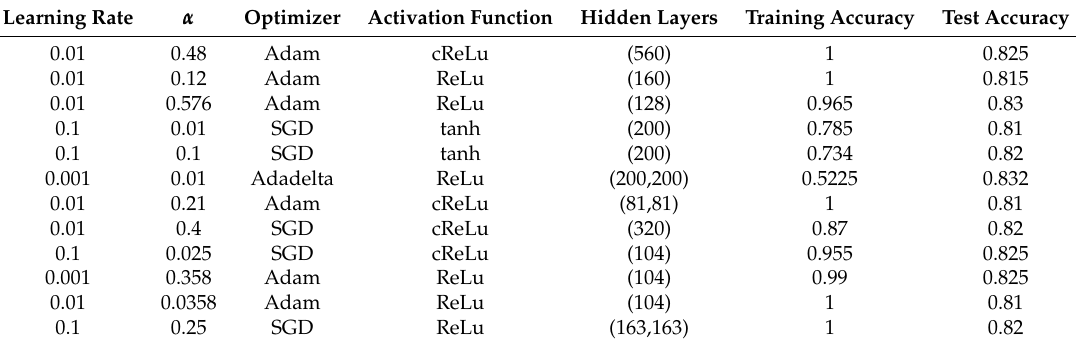
Table 3. Details of the MLP configurations represented in Figure